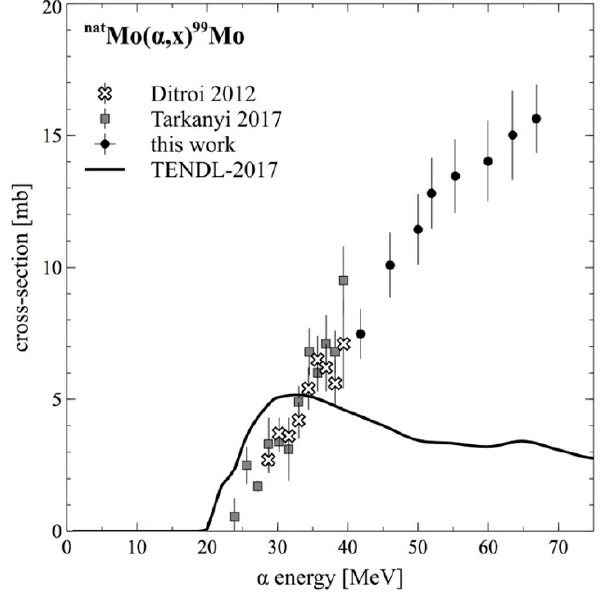
Figure 6. Measured cross-section for nat Mo( α ,x) 99 Mo reaction compared with the literature.